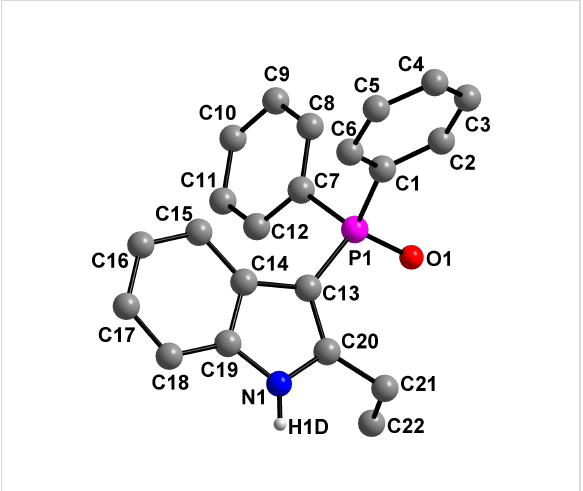
Figure 3: Molecular structure of compound 9 . Hydrogen atoms (except NH) are omitted for clarity. Selected bond distances (Å): P1–C13 1.771(2), C13–C20 1.385(3), C13–C14 1.450(3), C20–N1 1.360(3), C20–C21 1.489(3).